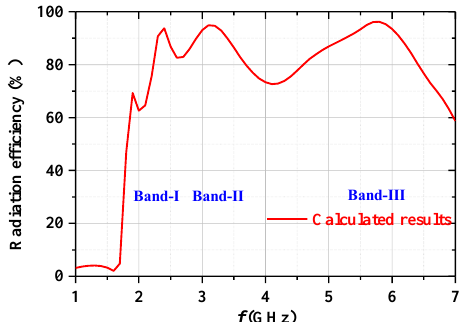
Figure 16. Radiation efficiency of the proposed antenna.